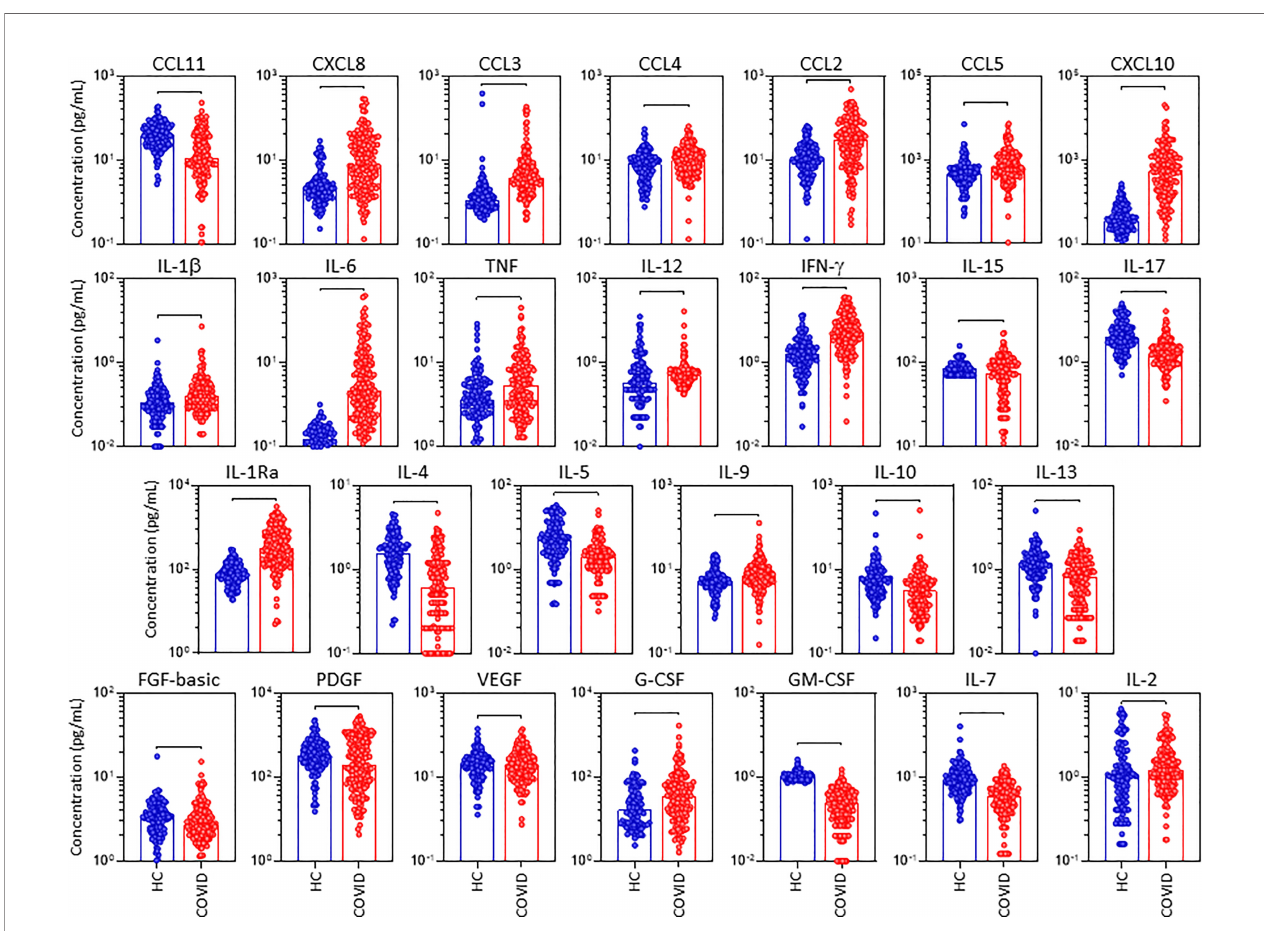
FIGURE 1 | Overall snapshot of serum soluble immune mediators in critically ill COVID-19 patients at ICU admission. The concentration of chemokines (CXCL8, CCL11, CCL3, CCL4, CCL2, CCL5, CXCL10), pro-in fl ammatory cytokines (IL-1 b , IL-6, TNF, IL-12, IFN- g , IL-15, IL-17), regulatory cytokines (IL-1Ra, IL-4, IL-5, IL-9, IL-10, IL-13) and growth factors (FGF-basic, PDGF, VEGF, G-CSF, GM-CSF, IL-7 and IL-2) were quanti fi ed in serum samples from critically ill COVID-19 patients – “ COVID ” ( ● , n = 183), as compared to pre-pandemic healthy controls – “ HC ” ( ● , n = 135) at ICU admission (D0=baseline). Measurements were carried by high- throughput microbeads array as described in Material and Methods section. The results are expressed in pg/mL and presented as scattering distribution of individual values over bar plots underscoring the median value on each bar. Signi fi cant differences at p <0.05 are indicated by connecting